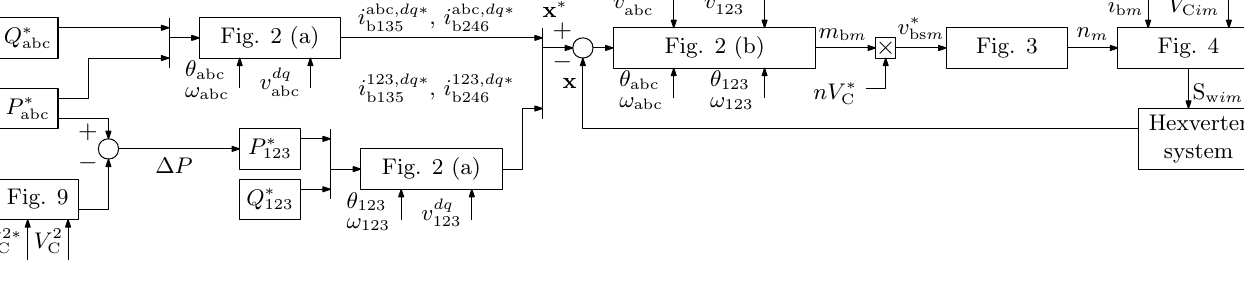
Figure 10. Hexverter-based system